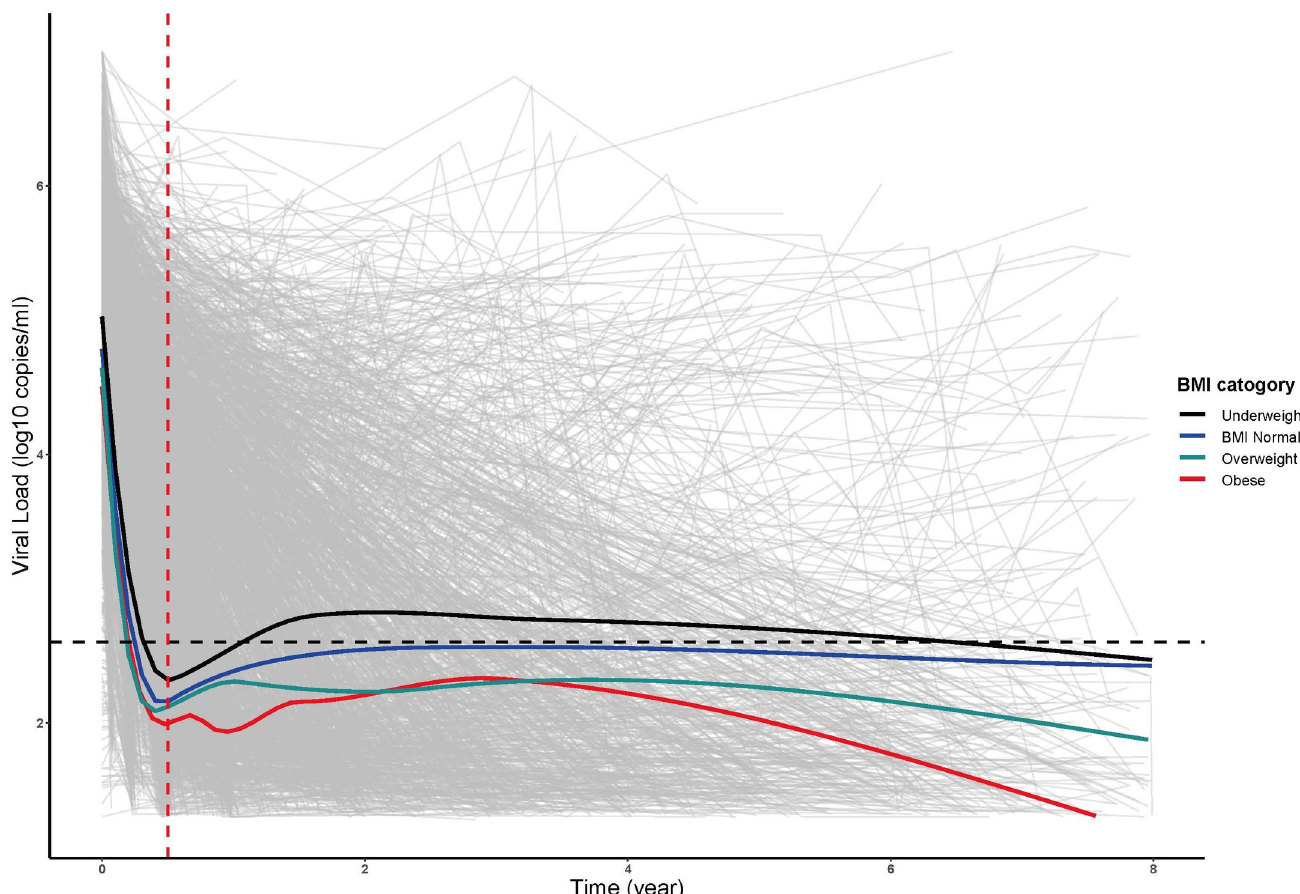
Fig 4. The fitting curve of viral load changes in different BMI categories (the black dotted line indicates that the viral load is 400 copies/ml; red dotted line indicates the 6th month of follow-up).